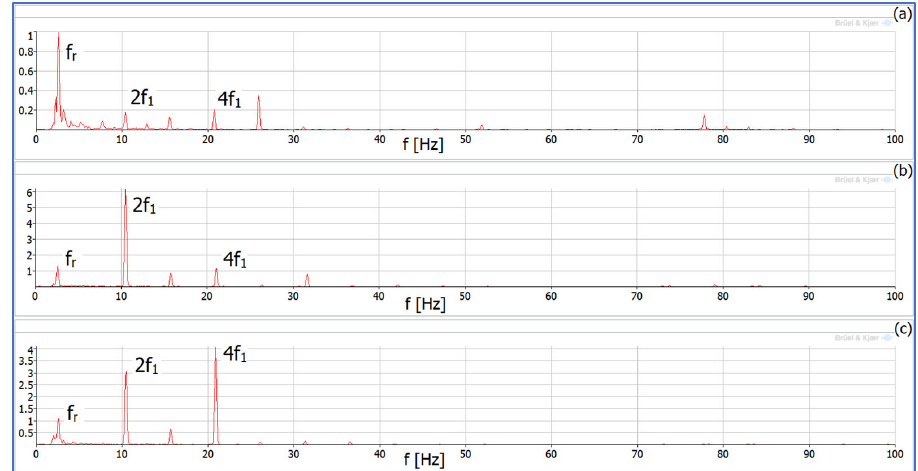
Figure 11. Vibration spectral characteristics for a rotational speed of 150 rpm and no load, where